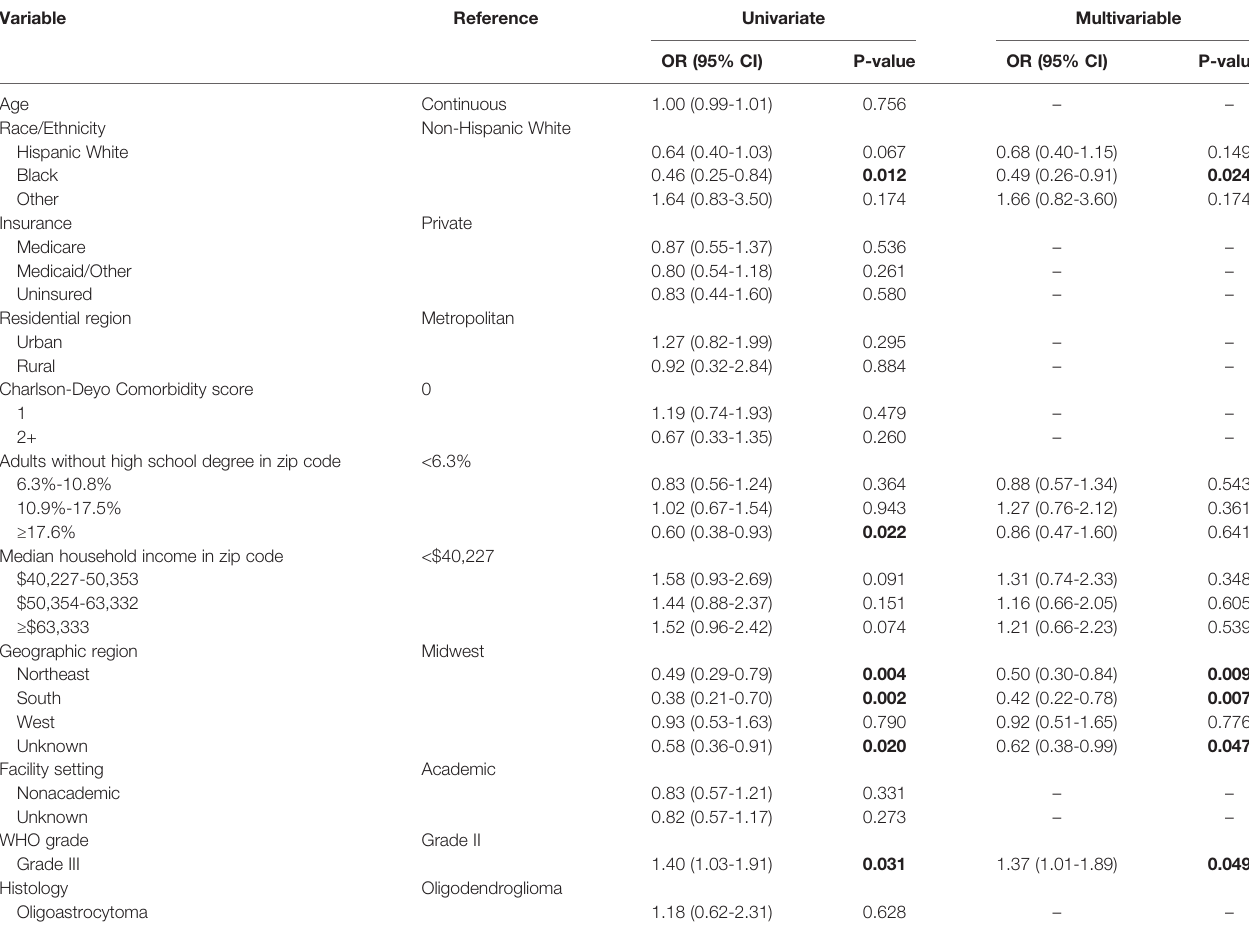
TABLE 4 | Univariate and multivariable logistic regression evaluating factors associated with reporting of a 1p/19q codeletion test for patients diagnosed in